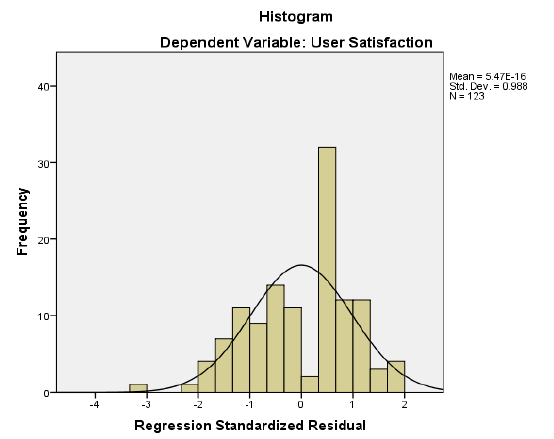
Future Internet 2019 , 11 , x FOR PEER REVIEW Figure 4. Histogram regression standardized residual. Figure 4. Histogram regression standardized residual.